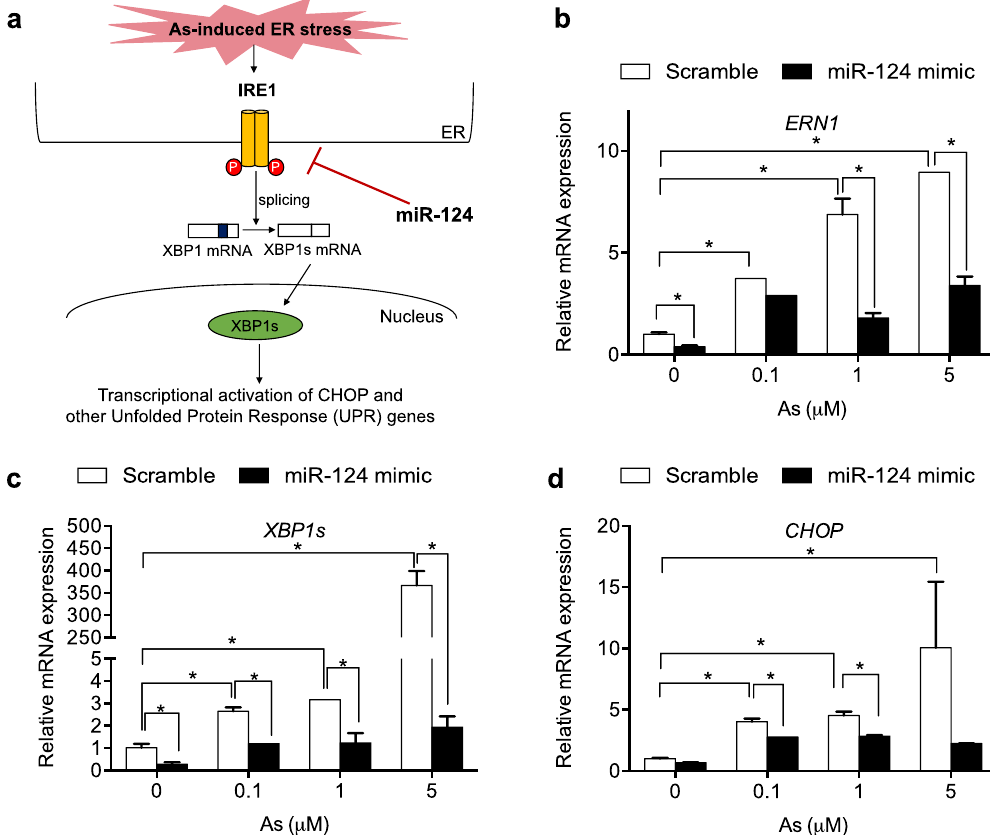
Figure 1. Mir-124 suppresses As-induced IRE1 ER stress/UPR pathway in human neural cells ( a ) Schematic of As-induced activation of the IRE1 ER stress/UPR pathway. Mir-124 specifically down-regulates IRE1 expression to suppress XBP1 splicing and CHOP activation 35 . ( b–d ) Effect of miR-124 on As-induced ER stress response. SH-SY5Y neuroblastoma cells were transfected with scramble or miR-124 mimic (10 pmol/well), then exposed to As for 4 h. Expression of ERN1 (gene encoding IRE1), XBP1s (spliced XBP1), and CHOP was measured by qRT-PCR. N = 3 experiments. All error bars represent the standard error of the mean of three biologic replicates. * p <